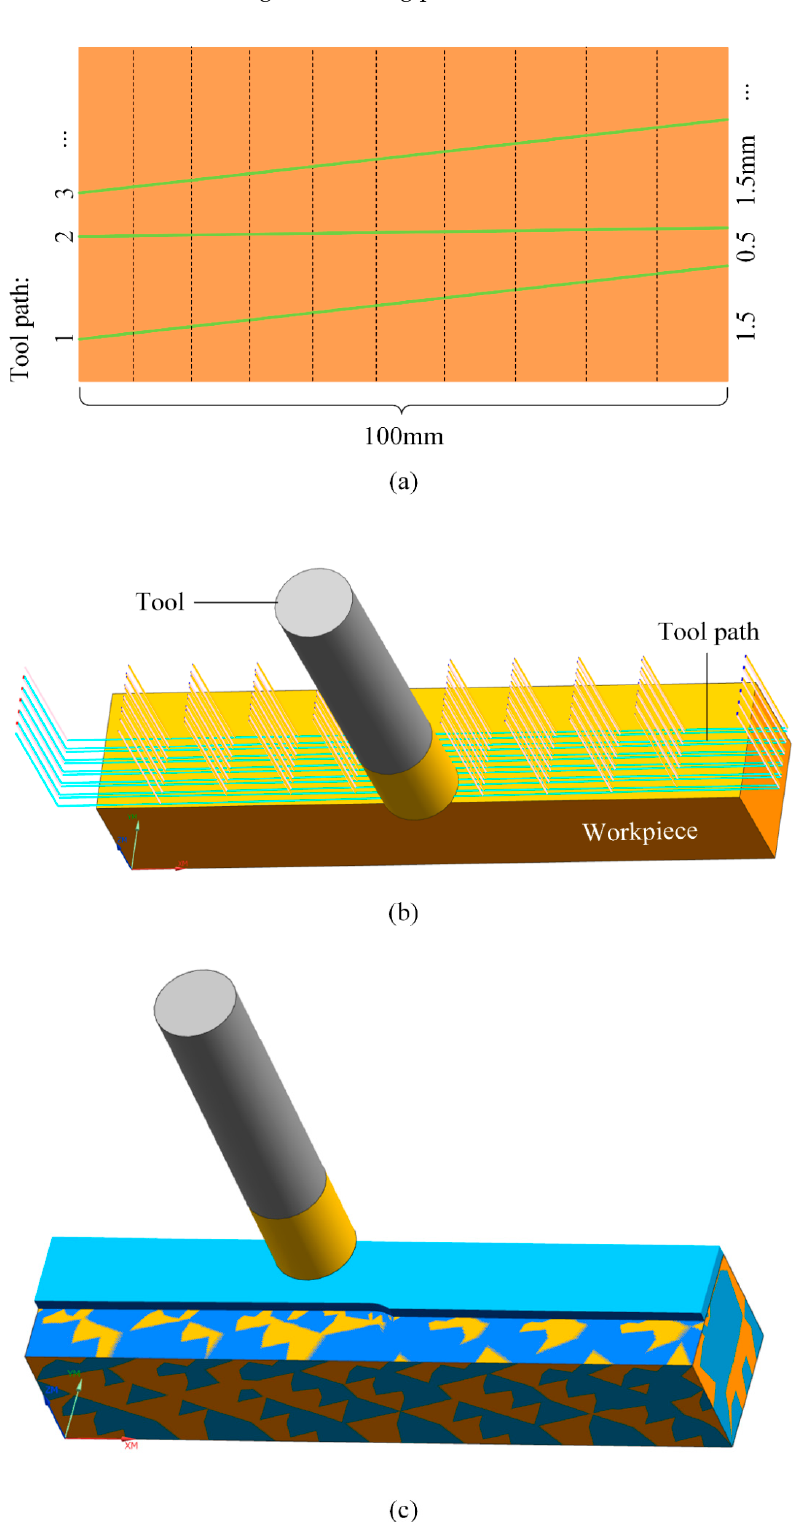
Figure 8. Tool path of varying depth milling: ( a ) tool path design, ( b ) tool path, ( c ) cutting process simulation.